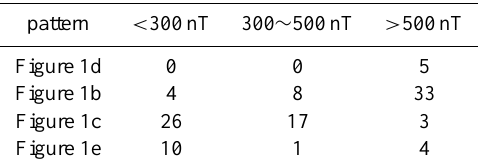
Table 1. Number of traversals classified by the peak AE during 6h before the